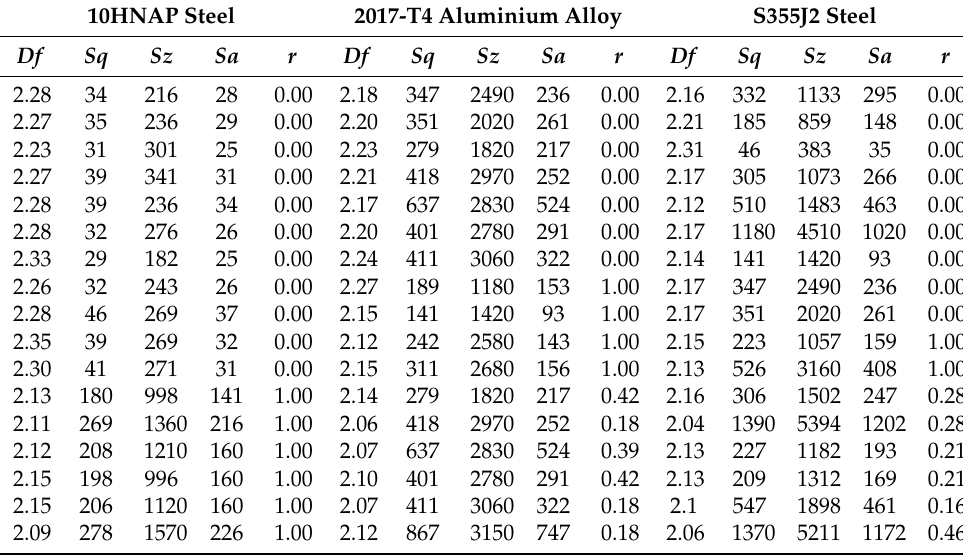
Table A1. Fractal dimension Df and areal surface Sx parameters versus loading stress ratio r for the studied